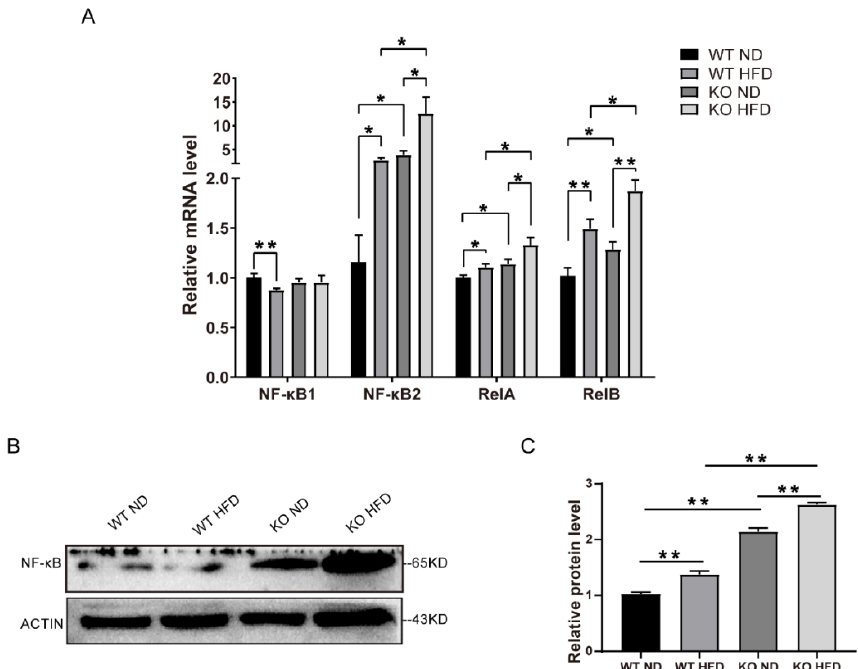
Figure 6. TRIM67 deletion activates NF- κ B pathway. ( A ) The mRNA levels of NF- κ B in hypothalamus ( n = 4). ( B ) The protein levels of NF- κ B in hypothalamus ( n = 3). ( C ) The gray value statistical analysis of NF- κ B ( n = 3). Four samples from each group were used for RT-qPCR analysis and two duplicate samples were measured. The data are presented as means ± SEM. * p -value < 0.05; ** p -value < 0.01.